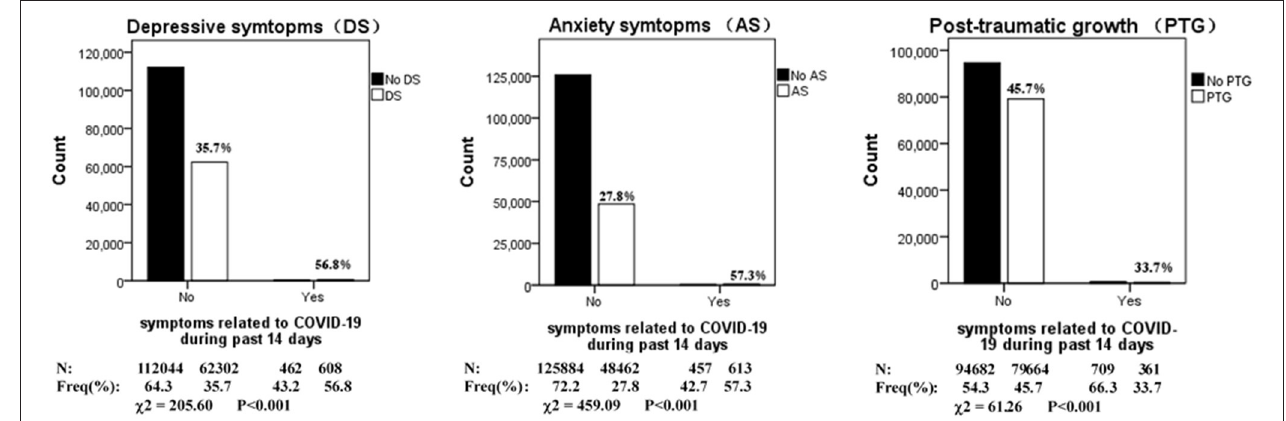
FIGURE 2 | Prevalence of depression, anxiety and PTG during COVID-19 outbreak in China, stratified by symptoms related to COVID-19 during past 14 days ( N = 175,416).